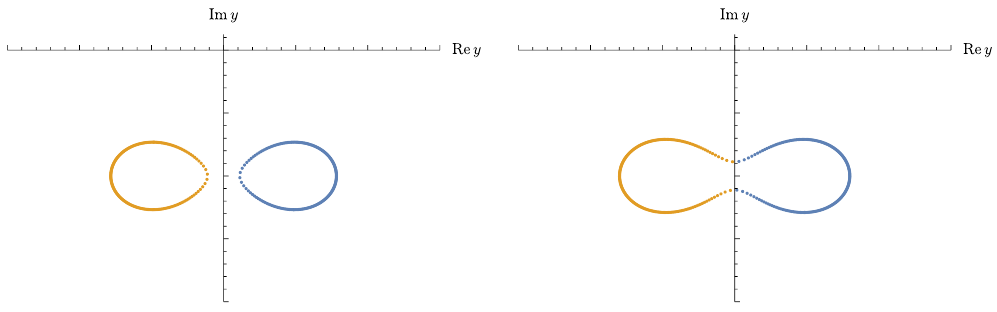
( x 2 ) of the spectral curve P 2 at complex x 2 = 2 | < | x 2 | (left panel) and | x 2 c 1